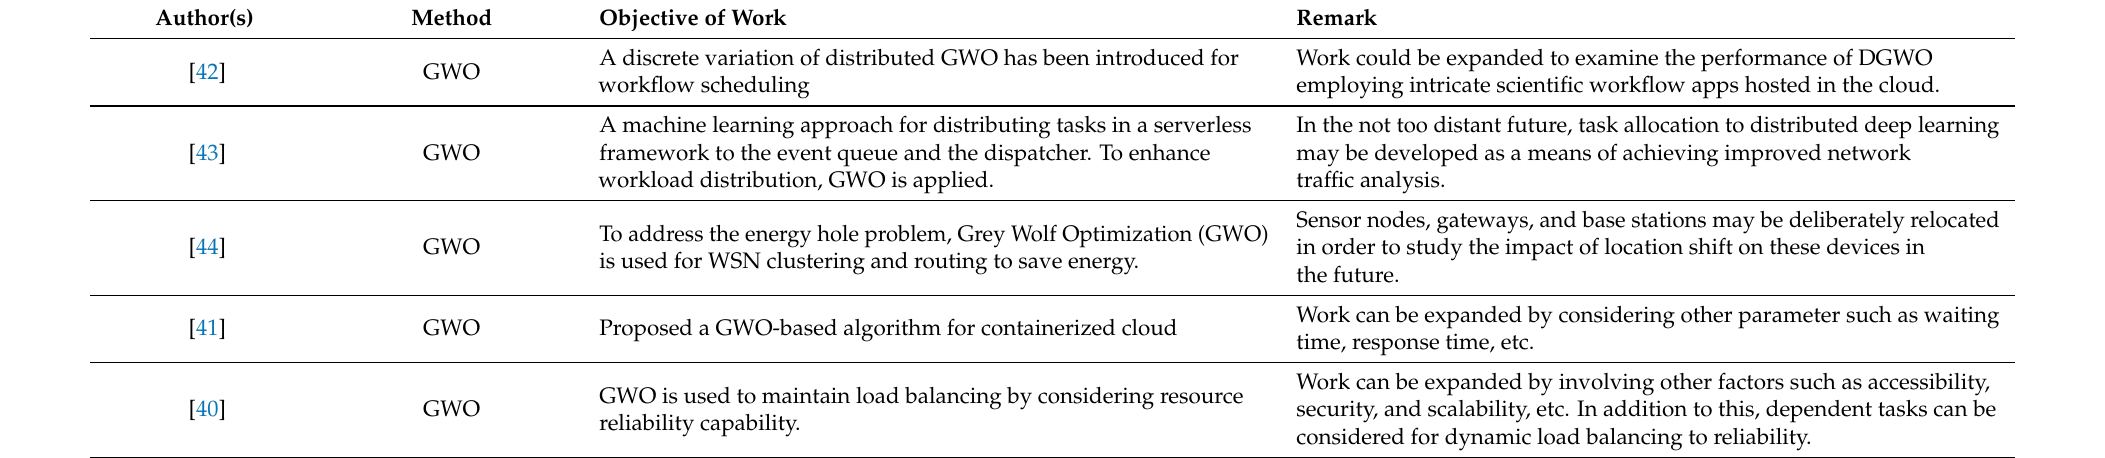
Table 3. Review of different Meta-heuristic Load Balancing Approaches Using